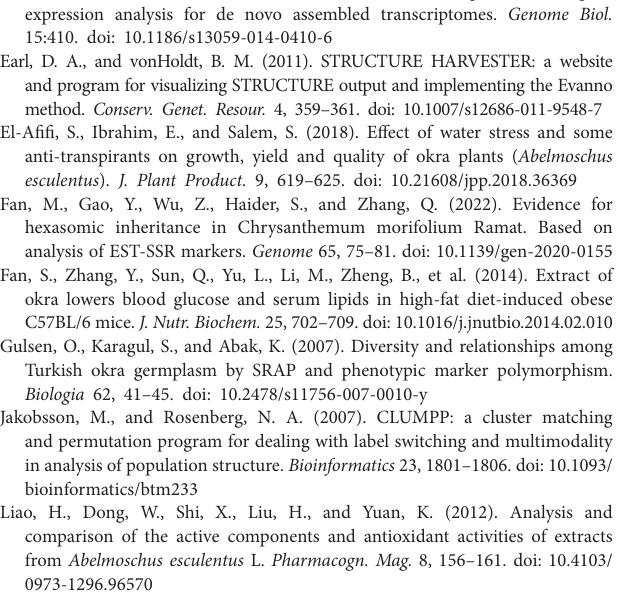
Supplemental Figure 1 | GO enrichment analyses of unigenes containing SSRs. Supplemental Figure 2 | KEGG enrichment analyses of unigenes containing SSRs. Supplementary Table 2 | Details regarding the EST-SSR primers used in this